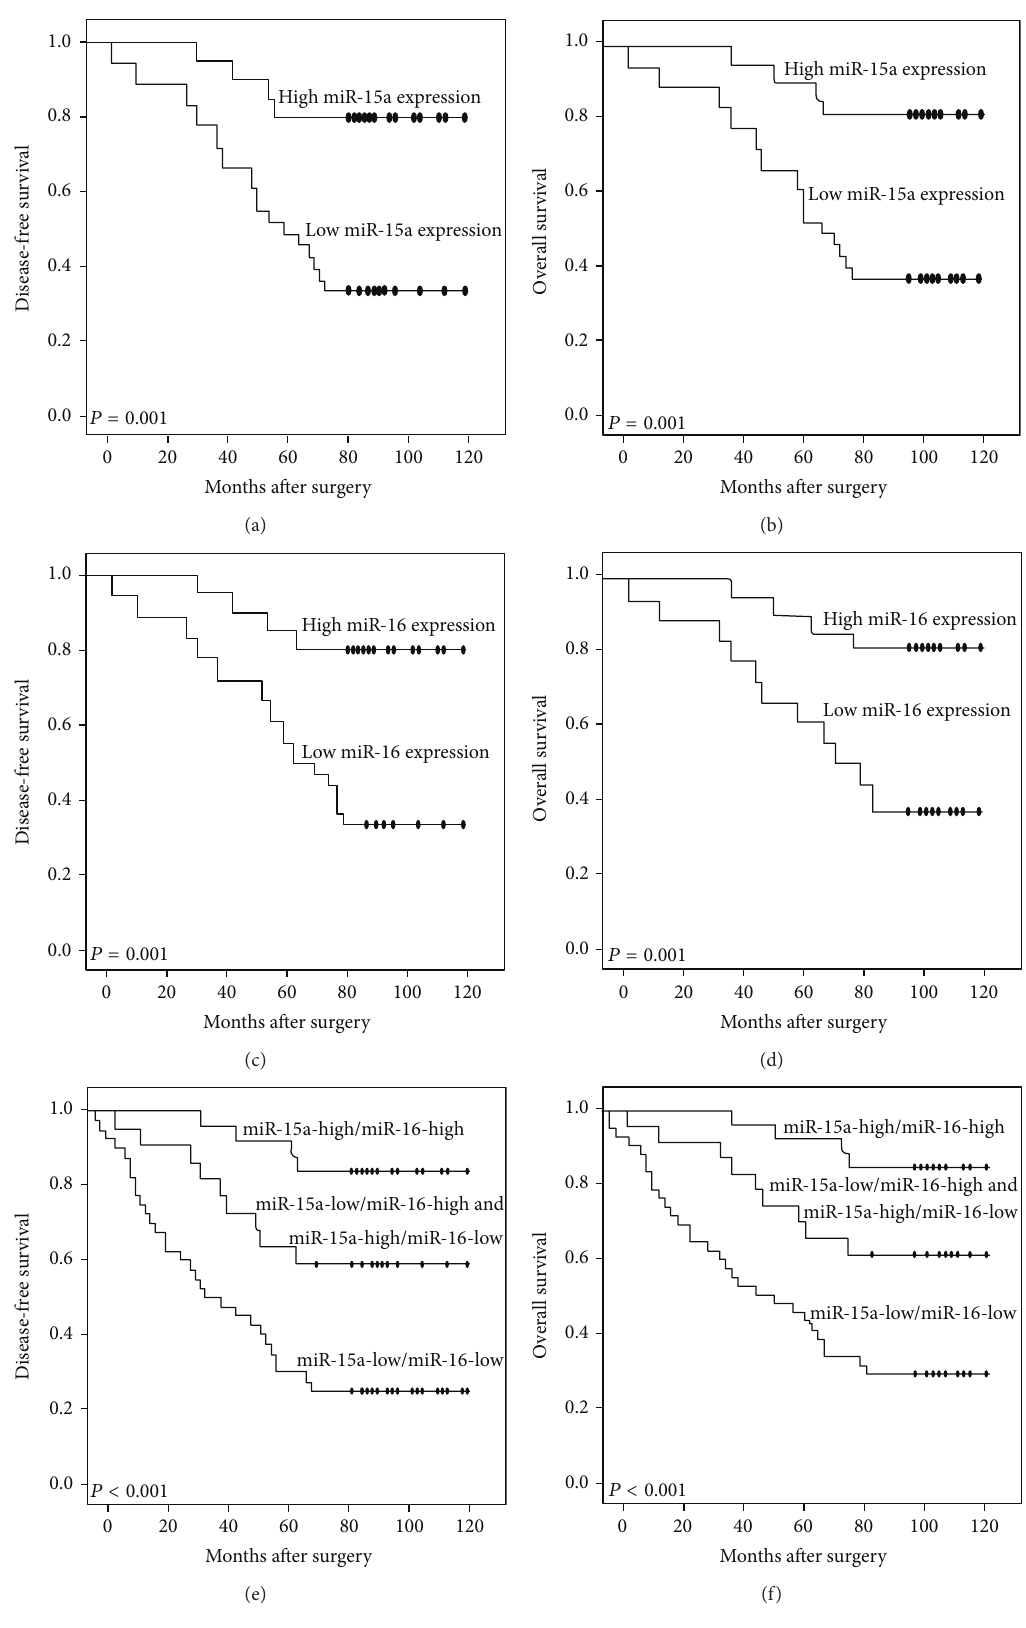
Figure 2: Kaplan-Meier survival curves of the disease-free survival and overall survival for miR-15a expression ((a) and (b), resp.), miR-16 expression ((c) and (d), resp.), and combined expression miR-15a and miR-16 (miR-15a/miR-16 (e) and (f), resp.) in colorectal